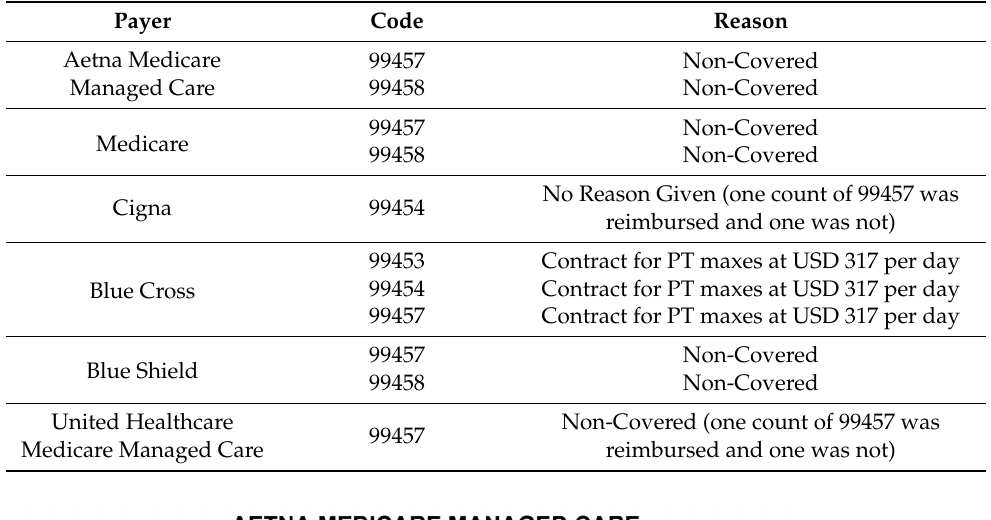
Table 8. List of reasons why specific RPM codes were denied by payers.